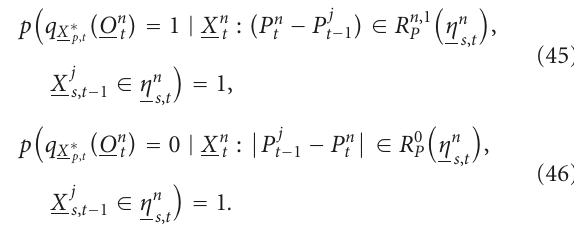
Global uncertainty over the motion of the whole object Uncertainty in shape dis- tortion of single GHT ele- ments from one frame to the next (rigidity of obser- vations with respect to the old shape)